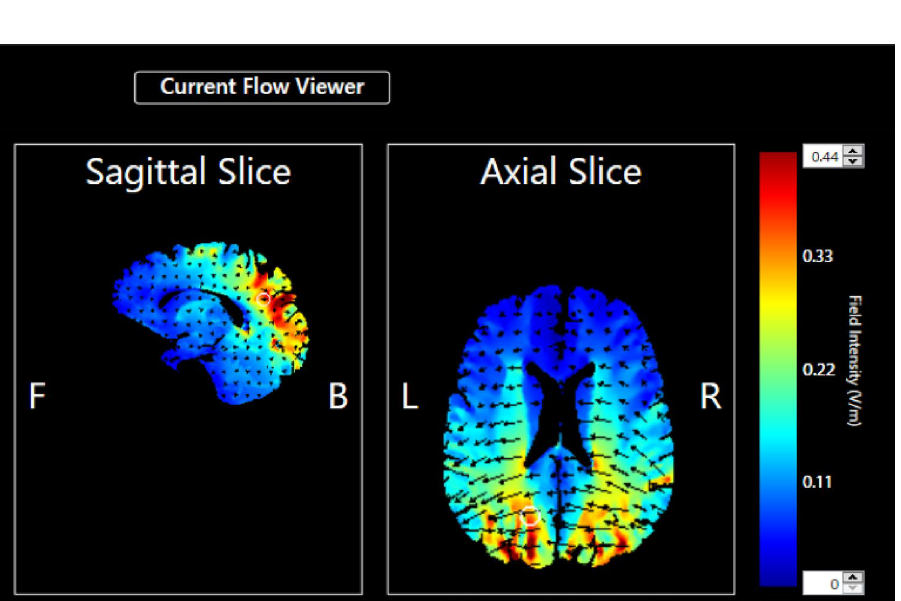
Figure 4. The result of cortical current flow simulation of transcranial direct current stimulation (tDCS) in the present experiment. The cathodal and anodal electrodes were assigned either P3 (left posterior parietal cortex, PPC) or P4 (right PPC). The stimulation induced an electric field of 0.4 V/m over both